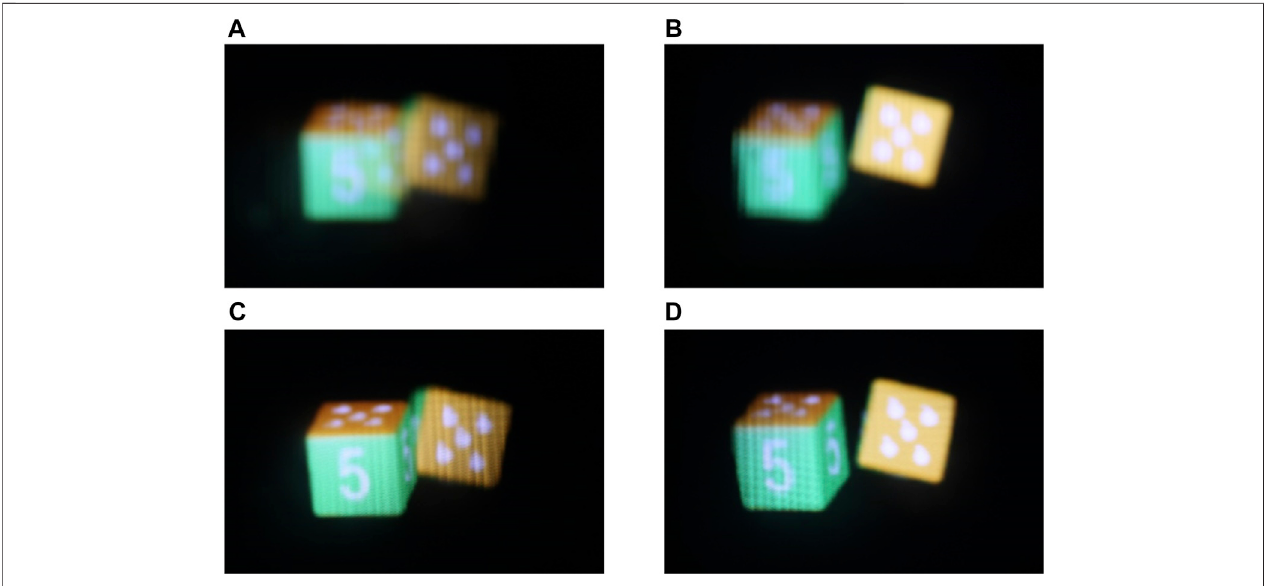
FIGURE 10 | Three-dimensional reconstruction results. SPOC algorithm: (A) left 7.1 ° viewing angle and (B) right 7.1 ° viewing angle. Average SPOC algorithm: (C) left 7.1 ° viewing angle and (D) right 7.1 ° viewing angle.